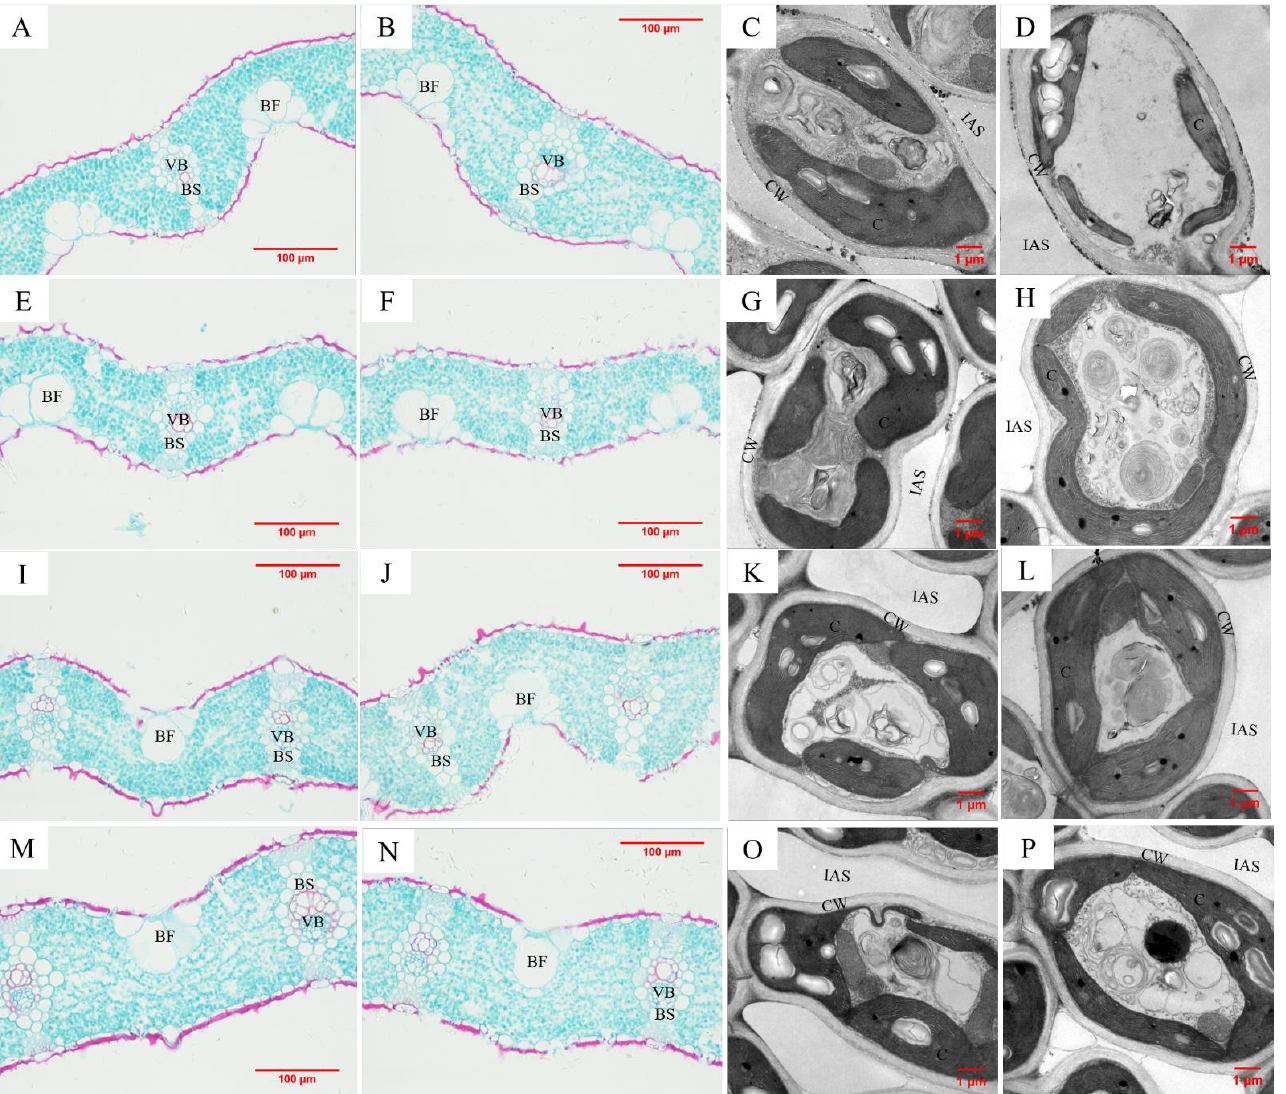
Figure 2. Light microscope and transmission microscope images of Sab Ini ( A – D ), N22 ( E – H ),